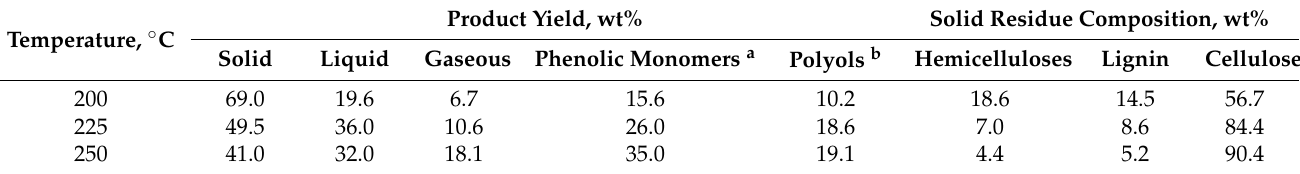
Table 5. The effect of temperature on the yield and composition of the products of spruce wood RCF (3 h) over the 3RS450